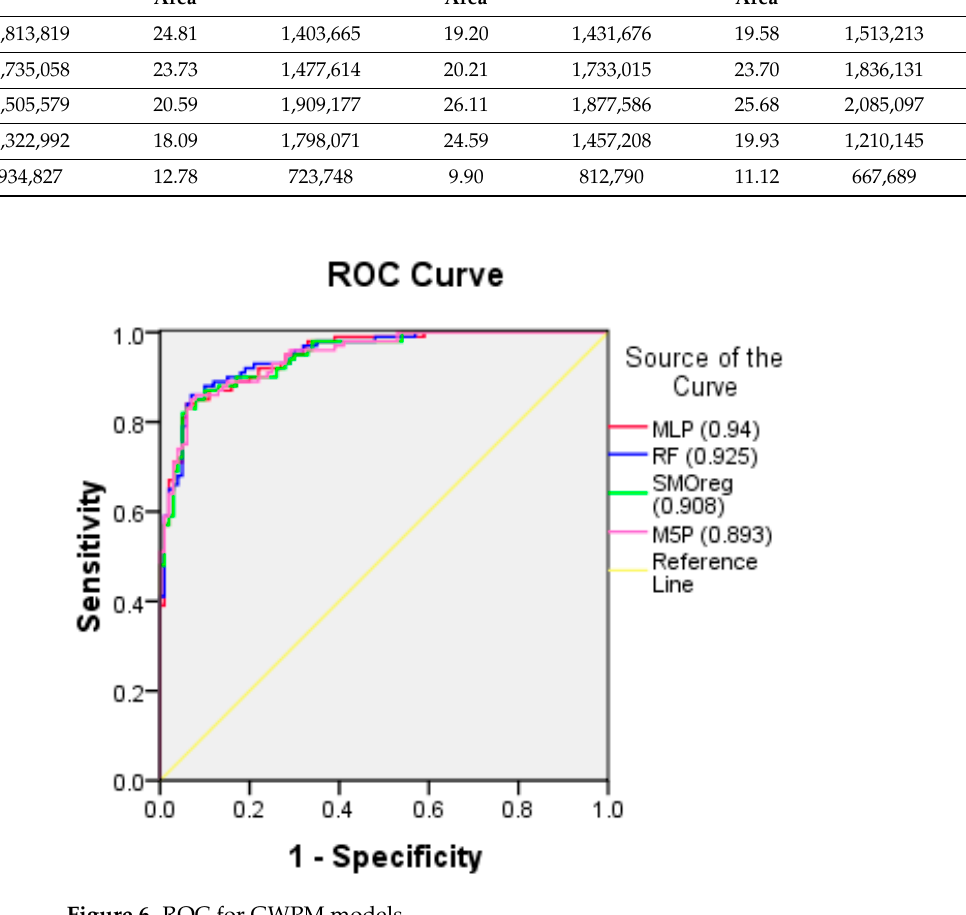
Figure 6. ROC for GWPM models. Table 4. AUC values under ROC curves for the training and testing datasets.